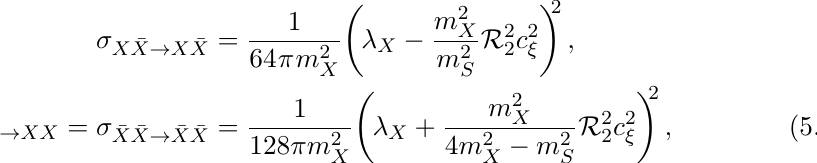
Figure 5 . Feynman diagrams for the DM self-interacting processes. The upper (lower) diagrams correspond to the process X (cid:22) X ! X (cid:22) X diagrams can be obtained by (cid:13)ipping the arrows in the lower